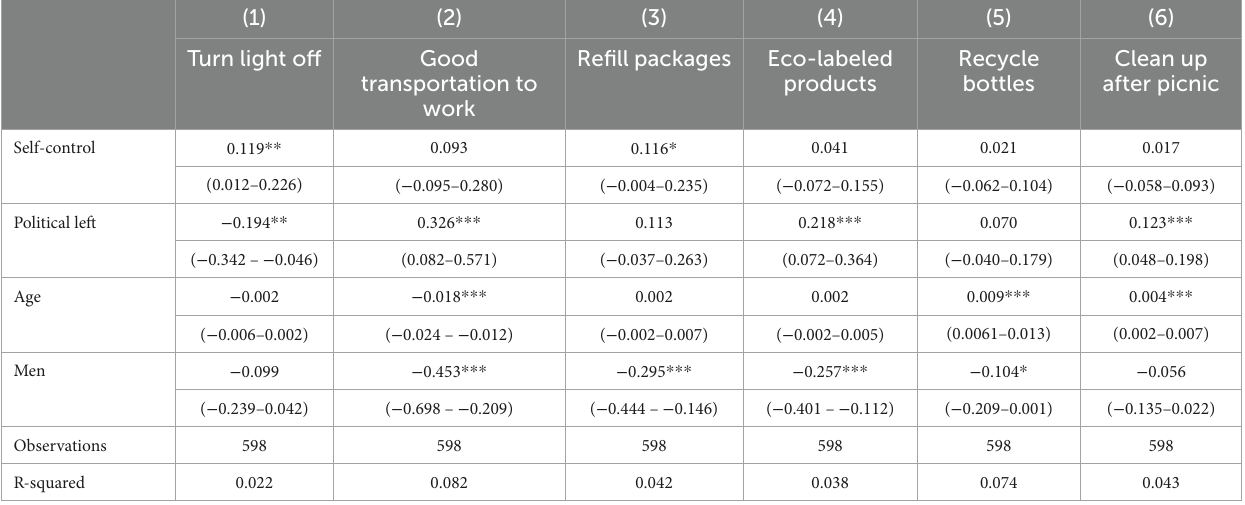
TABLE 6 Pro-environmental behaviors as functions of self-control, political orientation, and control